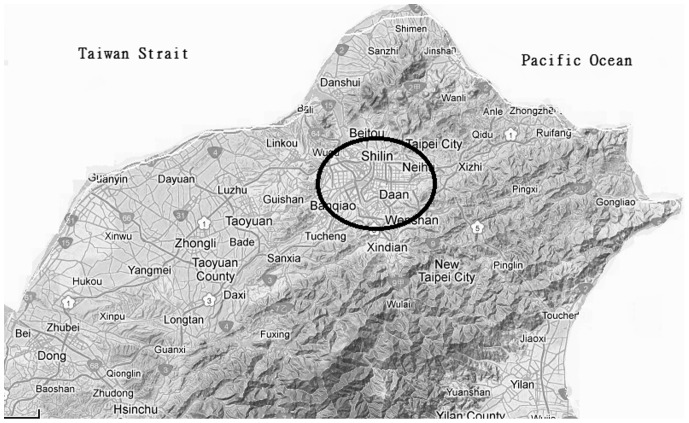
Terrain of northern Taiwan: The Taipei Basin (circle part, including most of Taipei City) which is surrounded by mountains and hills has 6 million people living in it.The map was cited from Google map with adjustment.